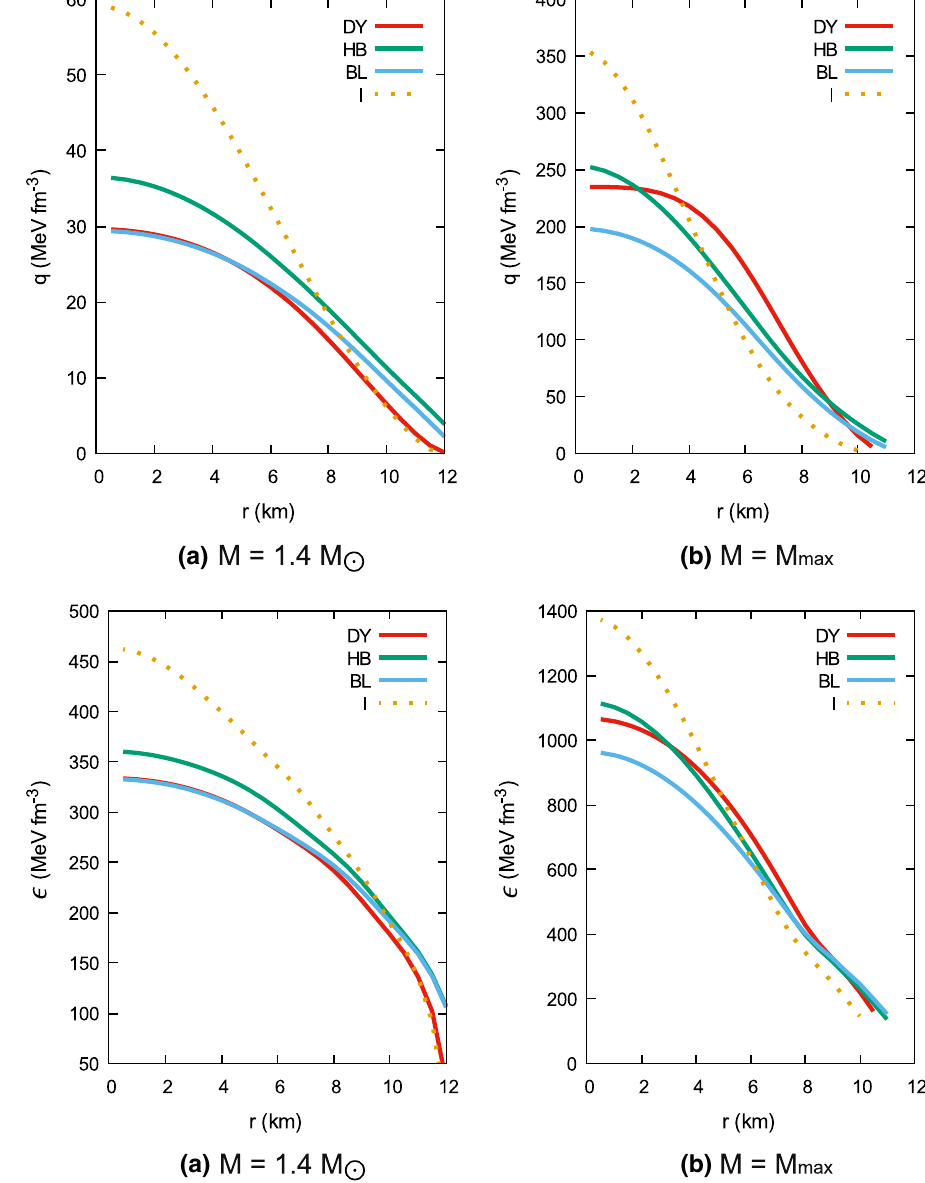
Fig. 3 Tangential pressure of anisotropic models NSs and its isotropic (I) for M = 1 . 4 M (cid:6) and M = M max